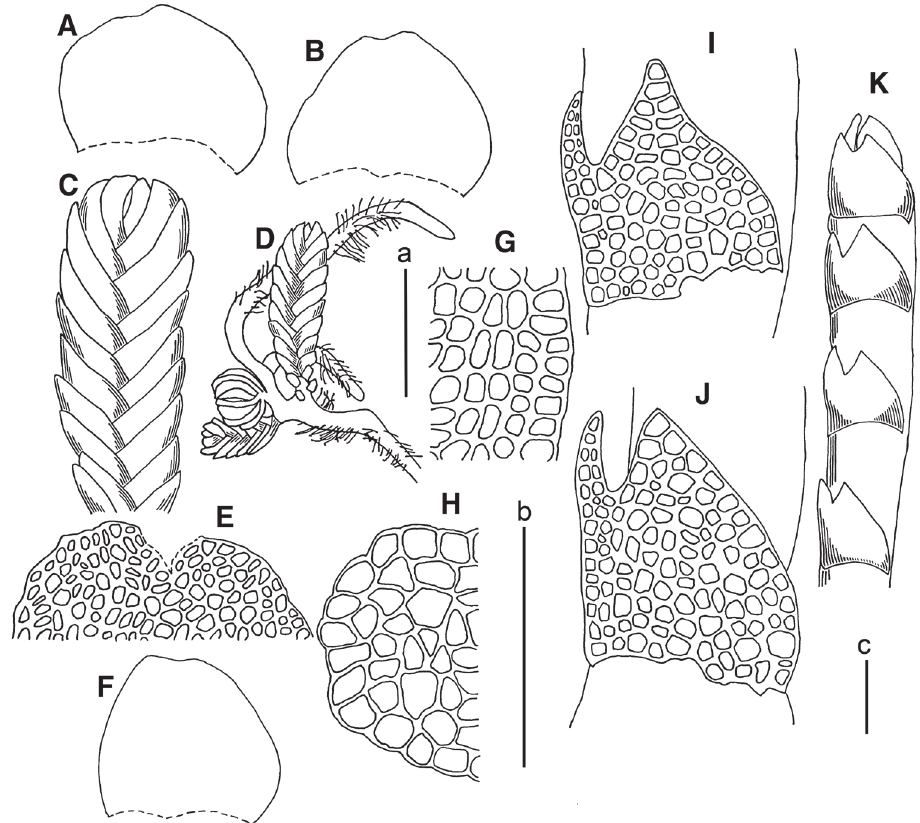
Figure 7. Gymnomitrion noguchianum S.Hatt. A, B, F leaves C plant habit (fragment) D plant habit E lacerate leaf apex G cells along leaf margin H stem cross section (fragment). All from Choi 120826 (JNU); Marsupella vermiformis (R.M.Schust.) Bakalin et Fedosov I, J leaves K plant habit (fragment). All from Choi 120911 (JNU). Scale bars: a 250 μm ( A–C, F ); a 500 μm ( D ); b 100 μm ( E, G–J ); c 100 μm ( K